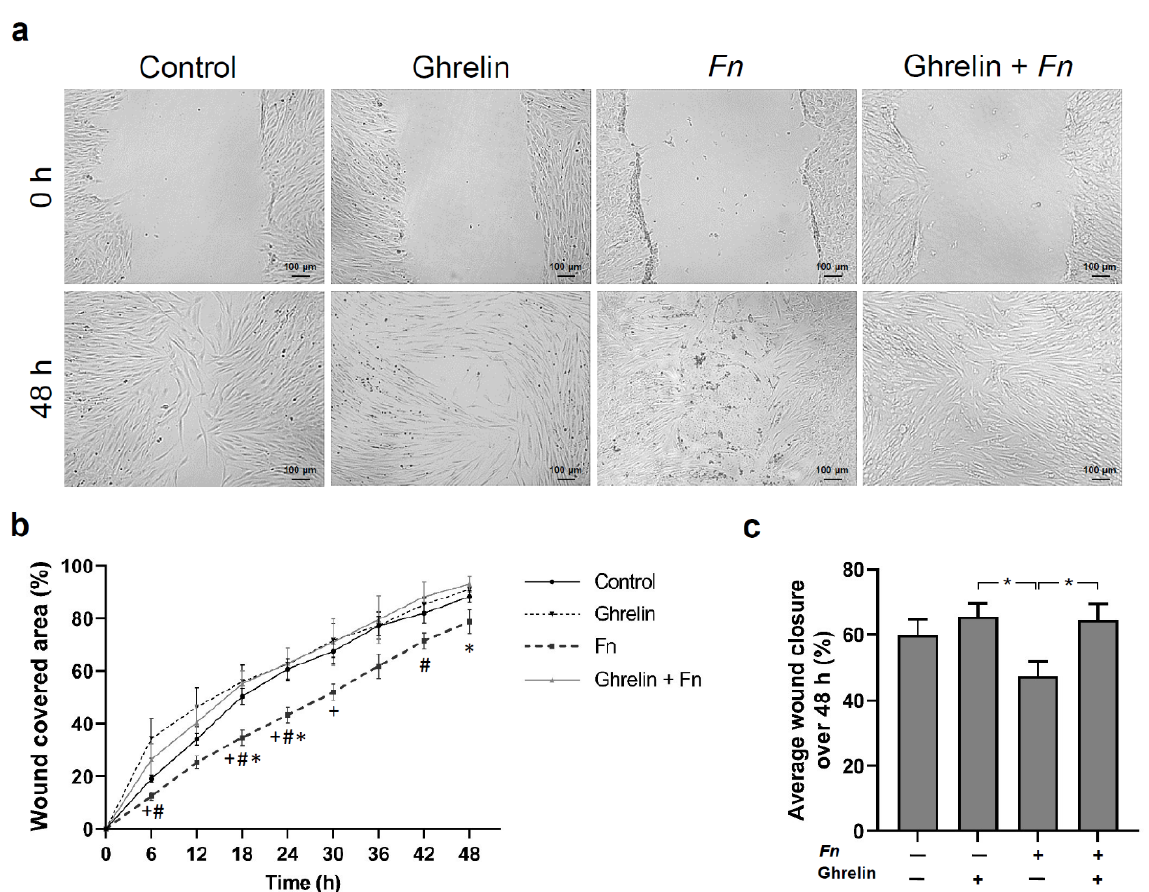
Figure 5. ( a ) Representative images of cell coverage from one donor at 0 and 48 h. ( b ) Percentage of cell coverage area in scratched HGF monolayers in the presence or absence of F. nucleatum ( Fn ATCC 25586, OD 660 : 0.1) and/or ghrelin (20 nM) over 48 h. Mean ± SEM ( n = 6). + Significantly different from control, # Significantly different from ghrelin, * Significantly different from ghrelin + Fn. ( c ) Percentage of average wound closure of scratched HGF monolayers shown in b in the presence (+) or absence ( − ) of F. nucleatum ( Fn ATCC 25586, OD 660 : 0.1) and/or ghrelin (20 nM). Mean ± SEM. * Significant ( p < 0.05) difference between groups. Unstimulated cells served as control.